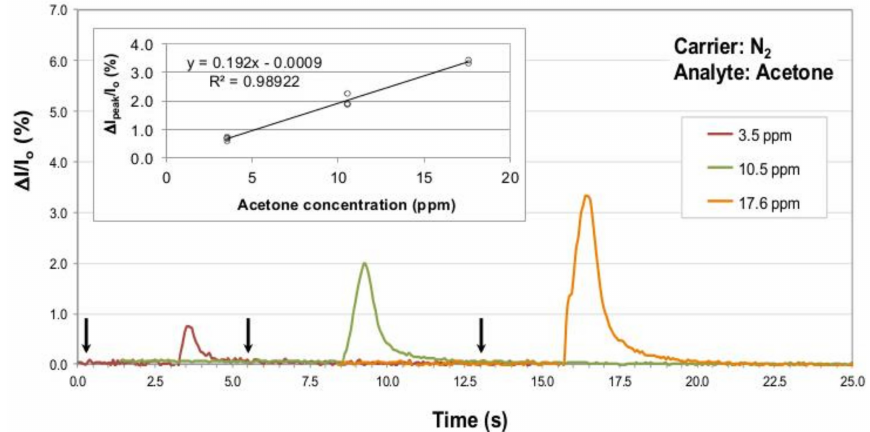
Figure 4. Current percentage change normalized to the baseline I 0 for a P3HT nanofibers sensor tested versus increasing acetone concentrations (namely, 3.5, 10.5 and 17.6 ppm) in nitrogen as the gas carrier, at 25 ◦ C. The black arrows mark the end of the analyte injection procedure (approximately three seconds prior to observe the sensor response onset; for the 17.6 ppm this time was a bit lower, around 2.5 s). The inset evidences the linear relation between the ∆ I peak /I 0 ratio and the considered acetone concentrations for all injections experiments conducted in nitrogen as gas carrier.